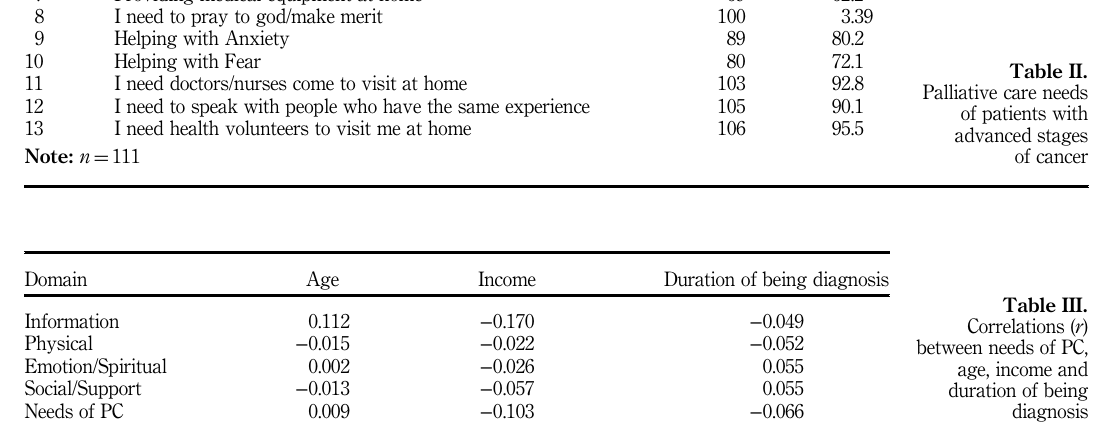
Table II. Palliative care needs